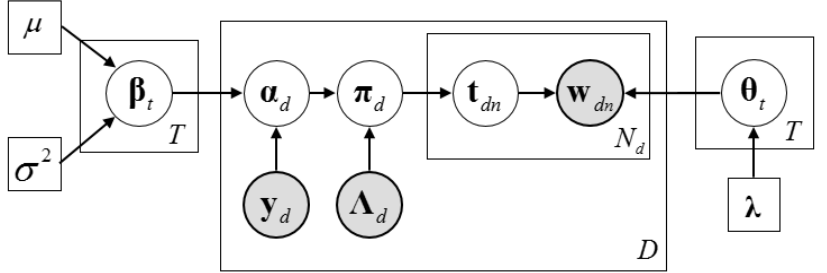
Figure 3. The graphic model of Dirichlet multinomial regression latent Dirichlet allocation